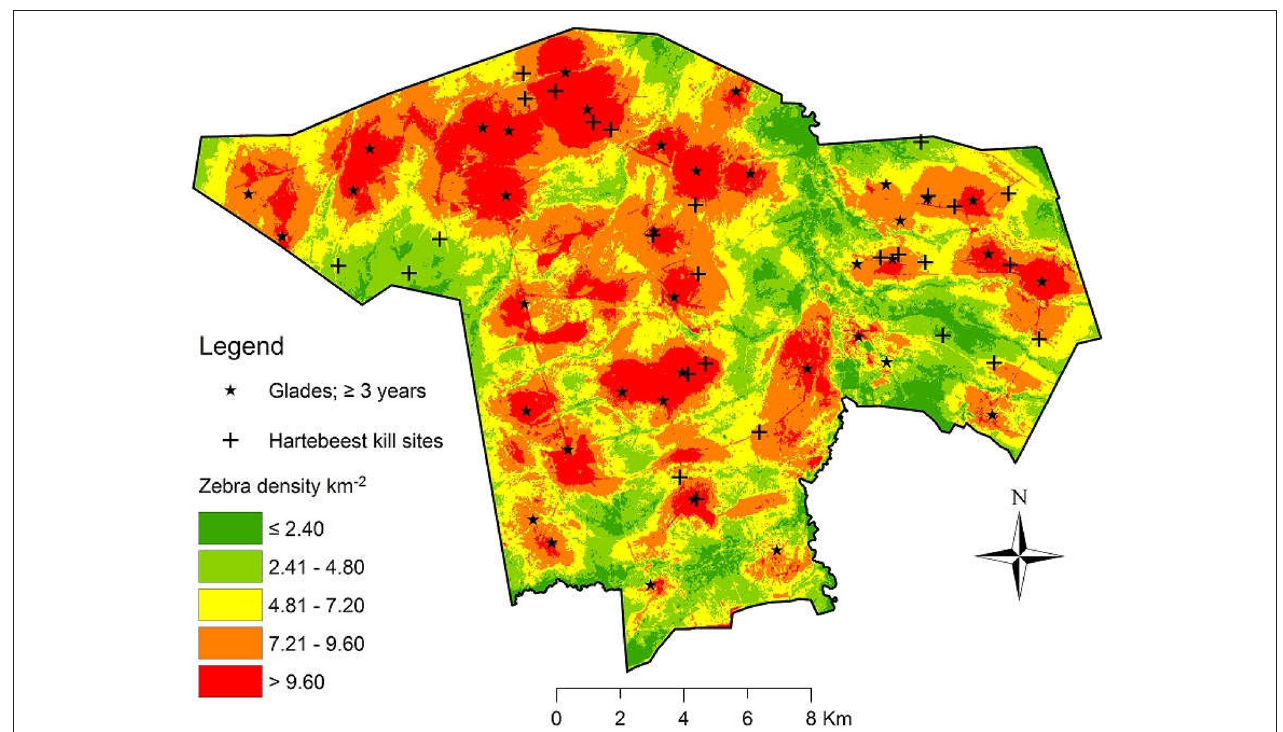
FIGURE 4 | Map with the locations of glades ( ≥ 3 years of age, n = 37) and hartebeest kill sites ( n = 27) superimposed on a density surface for plains zebra. Estimates of zebra density (individuals/km 2 ) transitions from high (red) to low (green), and is driven largely by glade location.